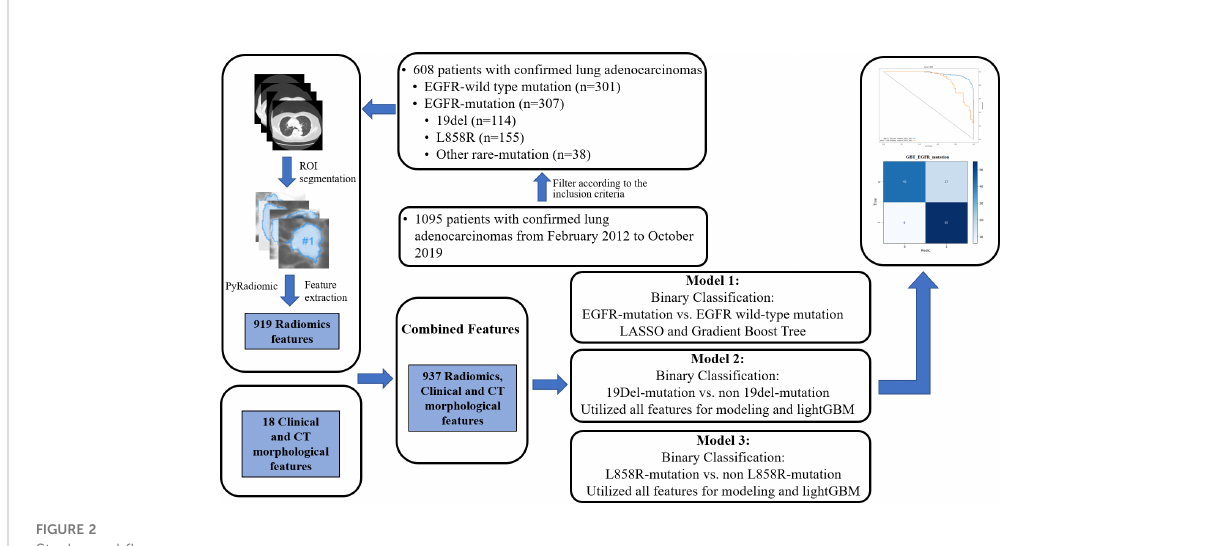
FIGURE 2 Study work fl